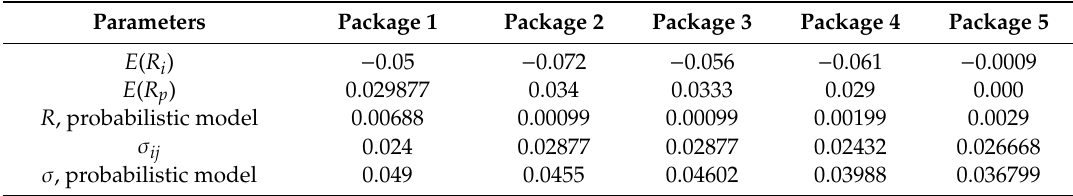
Table 2. Expected profitability and standard deviation of the profitability of corporate property packages at the boundaries of the membership